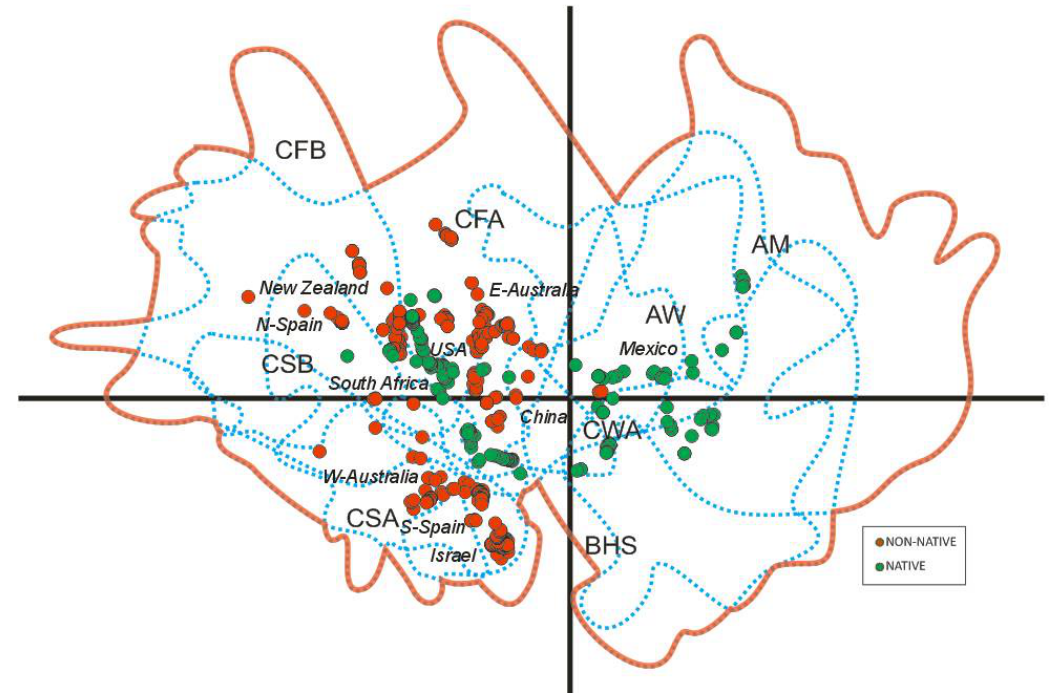
Figure 4. PCA biplot that represents the environmental space in the global realized niche of the species O. drummondii using the 19 bioclimatic variables of WorldClim. The dots show the occurrence records that were used to calibrate the models. Red color dots shows non-native records and green color dots shows native records. Blue dotted lines represent a fraction of the fundamental niche from each Köppen–Geiger climatic region. Orange line represents an approximation of the fundamental